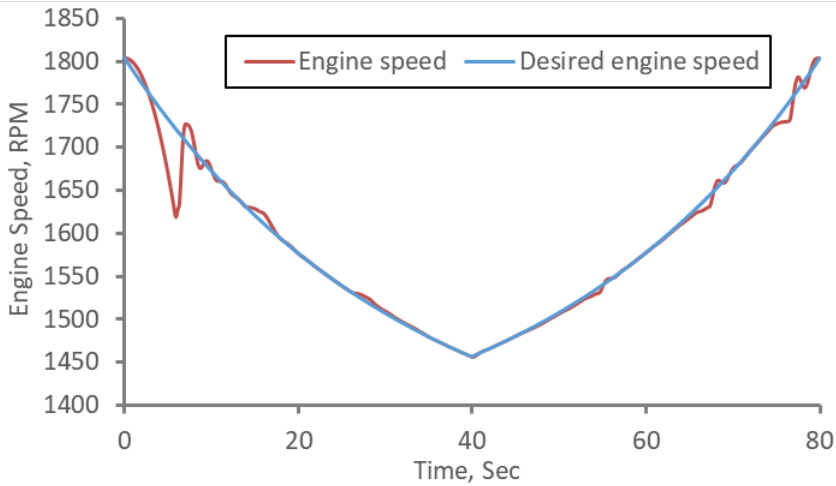
Figure 11. Response of engine speed controller from ramp input.